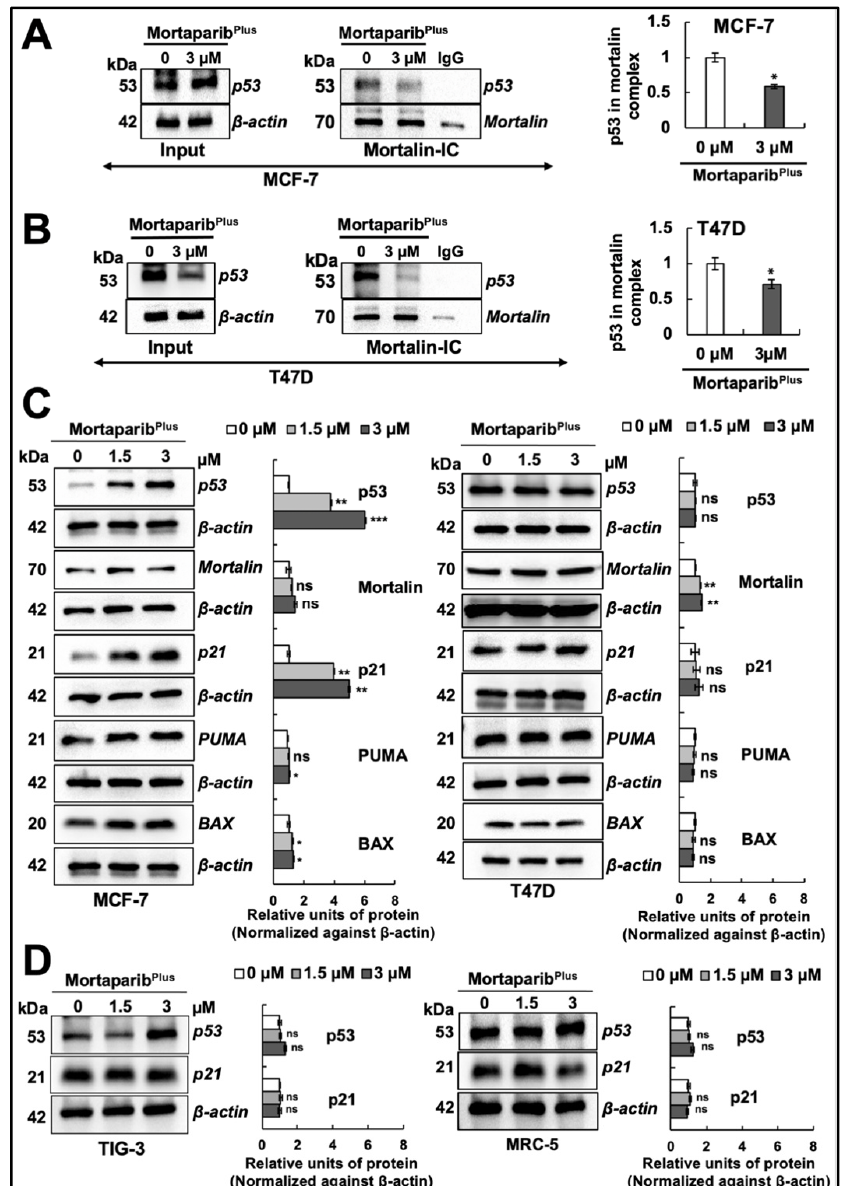
Figure 2. Mortaparib Plus abrogated the interaction of mortalin with p53 in vitro causing the reac- tivation of the wild-type p53 signaling. Co-immunoprecipitation (Co-IP) analyses using a rabbit monoclonal anti-mortalin antibody ( A , B ) showed a decrease in p53 fractions (wild type and mu- tant) in mortalin complexes immunoprecipitated from Mortaparib Plus -treated cells. Full uncropped blots for the Co-IP experiments are shown in Supplementary Figures S5 and S6. Control and 48 h- Mortaparib Plus -treated cells were analyzed for the expression levels of p53, mortalin and several p53 downstream target genes by Western blotting ( C ). An accumulation in p53 levels with the overexpression of its downstream target genes (p21 WAF1 , PUMA and BAX) was observed in 48 h- Mortaparib Plus -treated MCF-7, but not T47D, cells as compared to the untreated control. Control and Mortaparib Plus -treated normal lung fibroblasts were analyzed for the expression levels of p53 and p21 by Western blotting ( D ). TIG-3 and MRC-5 normal lung fibroblasts also did not show a significant increase in p53 or its downstream effector p21 WAF1 . Full uncropped blots for the Western blotting experiments are shown in Supplementary Figures S7–S14. The quantified data represent mean ± SD obtained from independent biological replicates; p -values were calculated using unpaired Student’s t -test. ns > 0.05, * ≤ 0.05, ** ≤ 0.01 and *** ≤ 0.001 represent non-sgnificant, significant, very significant and highly significant,